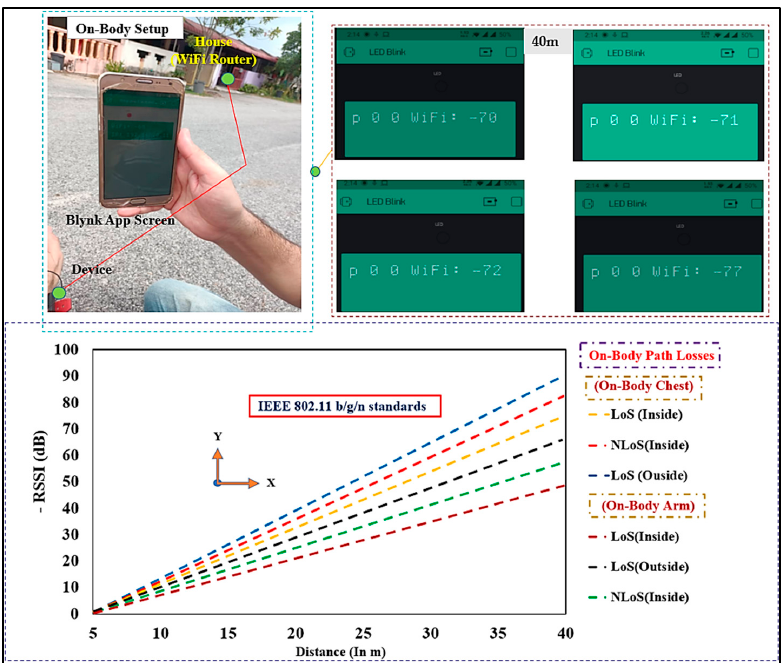
Figure 27. Measured RSSI in dB in on-body scenarios (Distance: 2 m to 40 m).